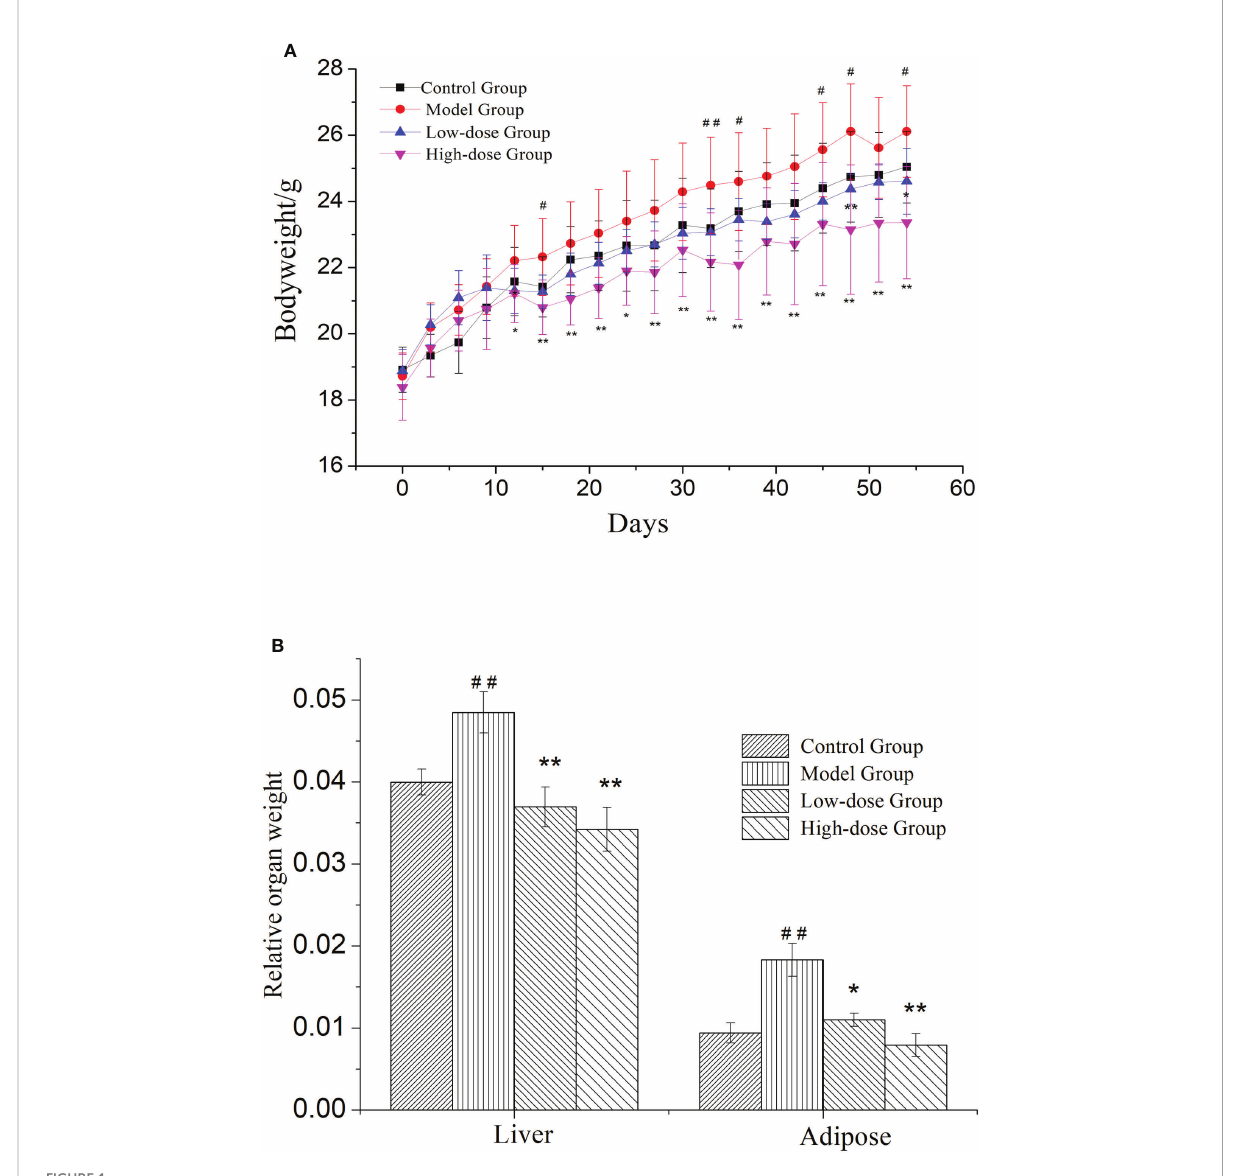
FIGURE 1 Effects of EMZAP on bodyweight (A) and relative organ weight (B) of mice (n = 10) * P < 0.05 and ** P < 0.01 vs Model Group, # P < 0.05 and ## P < 0.01 vs Control